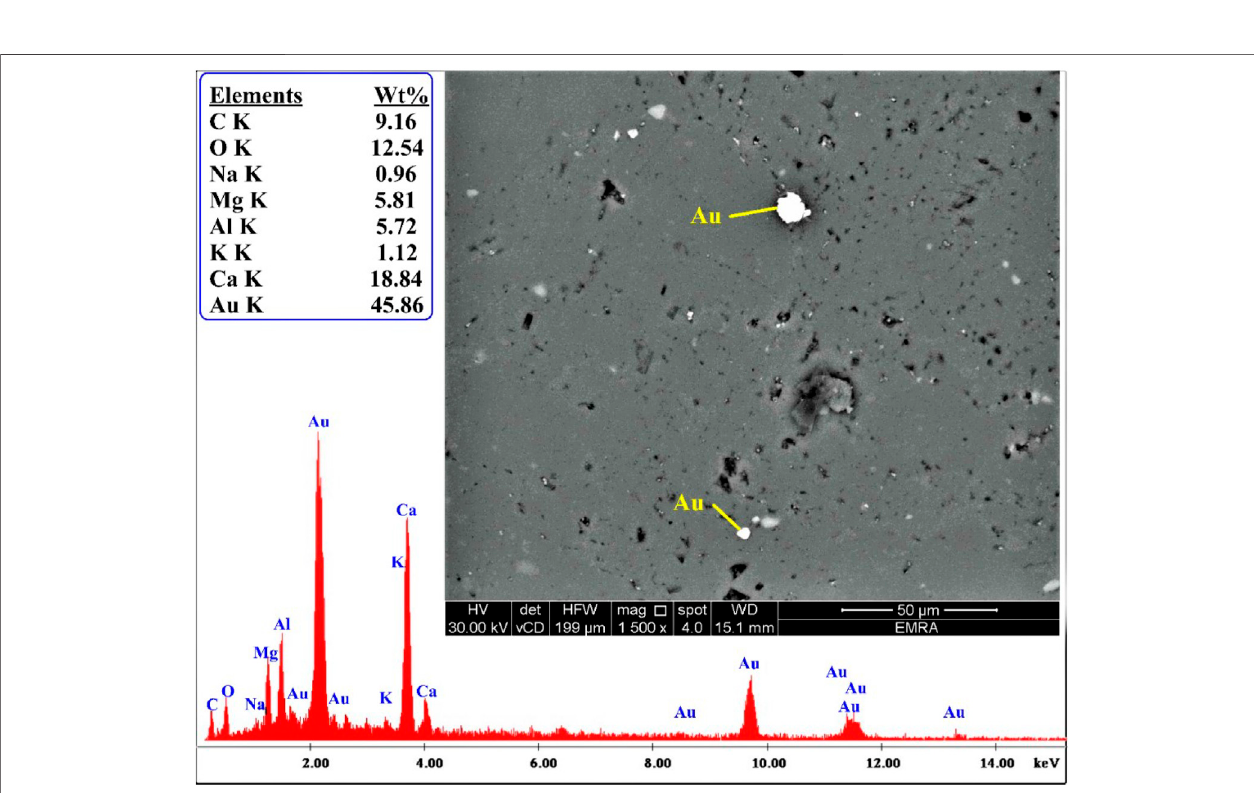
FIGURE 17 | SEM of gold nugget distributed in listwaenite rocks.